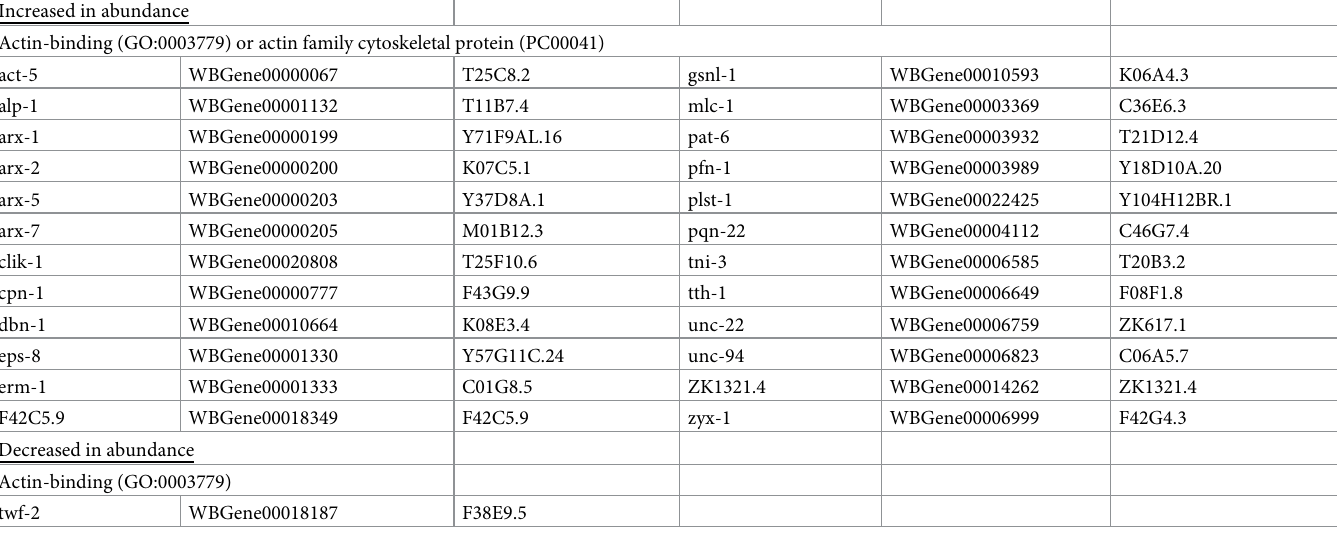
Table 1. Actin-related C . elegans glp-4(bn2) proteins altered by Cry5B feeding as detected by proteomics. Increased in